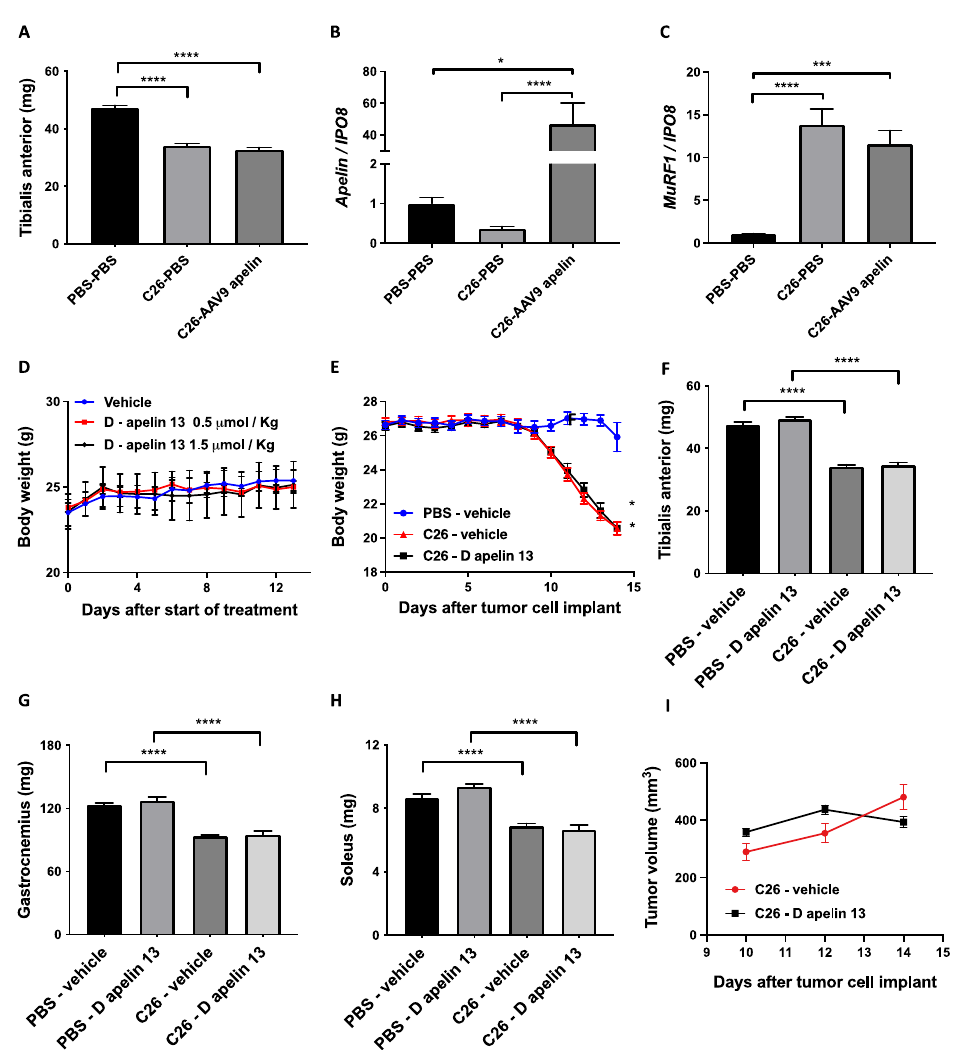
Figure 5. Intramuscular injection of preproapelin-expressing adenoassociated viruses or systemic treatment with D-apelin 13 do not protect muscles from cancer-induced wasting. Intramuscular injection of the preproapelin-expressing adenoassociated viruses type 9 (AAV9) does not preserve the TA from atrophy ( A ), even though the apelin gene is overexpressed in the muscle as shown by Q-PCR ( B ). C26-induced MuRF1 is not restrained by apelin overexpression ( C ). IPO8 is used to normalize the data. Ordinary one-way ANOVA, Kruskal – Wallis test, * p ≤ 0.05, *** p = 0.0001, **** p ≤ 0.0001, n = 8–18. Vehicle (H 2 O) or 0.5 or 1.5 μ mol/Kg D-apelin 13 were injected daily intraperitoneally in BALB/c mice and body weighs monitored over time. After 13 days, there were no differences in BWL among groups, excluding overt toxicity. Mouse body weights are plotted over time ( D ). One-way ANOVA for repeated measures, not significant, n = 3–4. C26 tumor cells subcutaneously injected in BALB/c mice cause BWL after 10 days from the injection, and D-apelin 13 does not preserve mouse body weight ( E ). One-way ANOVA for repeated measures, * p ≤ 0.05, n = 15. D-apelin 13 does not preserve muscles from atrophy induced by C26 cancer, as seen from TA ( F ), gastrocnemii ( G ) and solei ( H ) weighed at sacrifice, 14 days after tumor injection. Ordinary one-way ANOVA, **** p ≤ 0.0001, n = 15. Tumors were manually measured with a caliper. D-apelin 13 did not affect tumor growth rate ( I ). Multiple t -tests, not significant, n = 15.